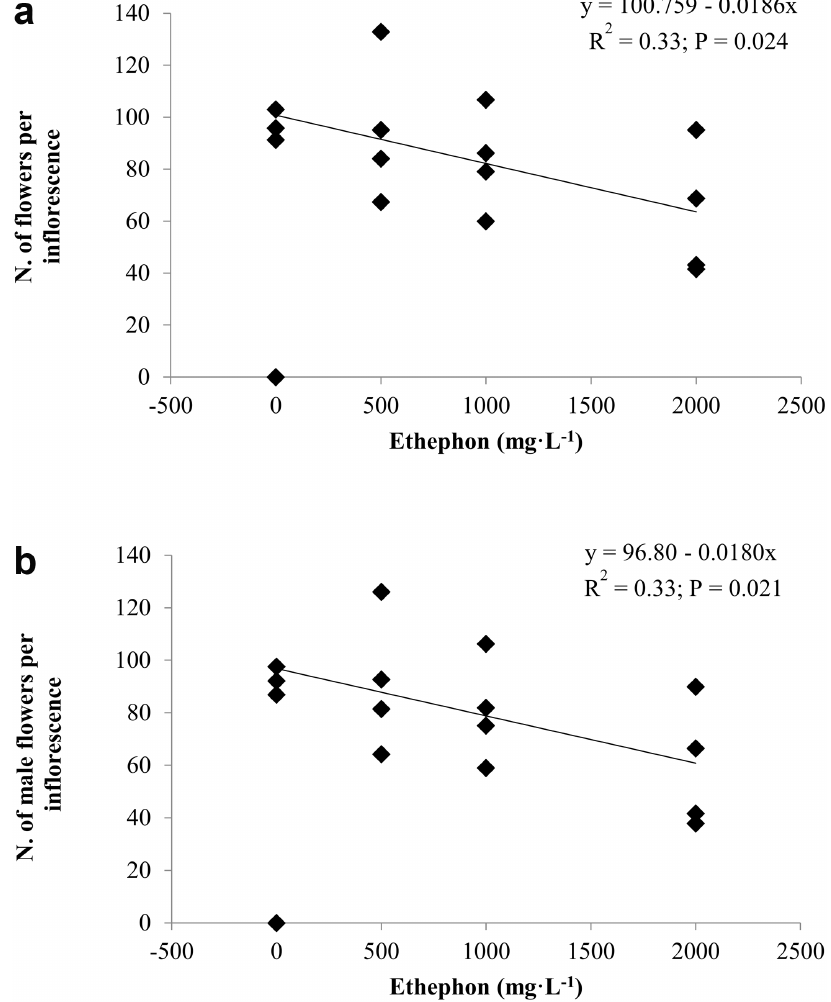
Figure 1 - Number of fl owers per in fl orescence ( a ) and number of male fl owers per in fl orescence ( b ) in Jatropha curcas L. plants treated with ethephon (Florel ® ) at 0, 500, 1000, or 2000 mg . L -1 . Plants were treated in May 2011 (n= 4). Values are means of 8 in fl orescences randomly selected for each plant, with a total of 32 in fl orescences per